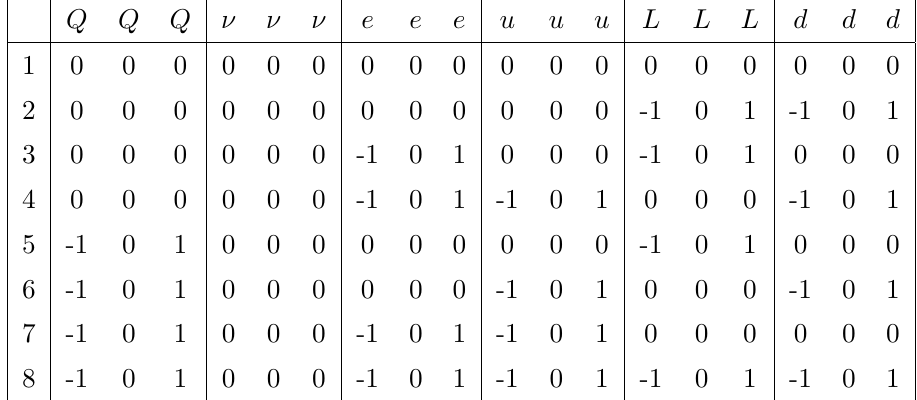
Table 1 . Inequivalent solutions to the anomaly equations for SM fermion content and Q max = 1. Each row shows an anomaly-free U(1) F charge assignment. Note that the charges within a species are labelled in increasing order from left to right and so the ordering does not re(cid:13)ect the family